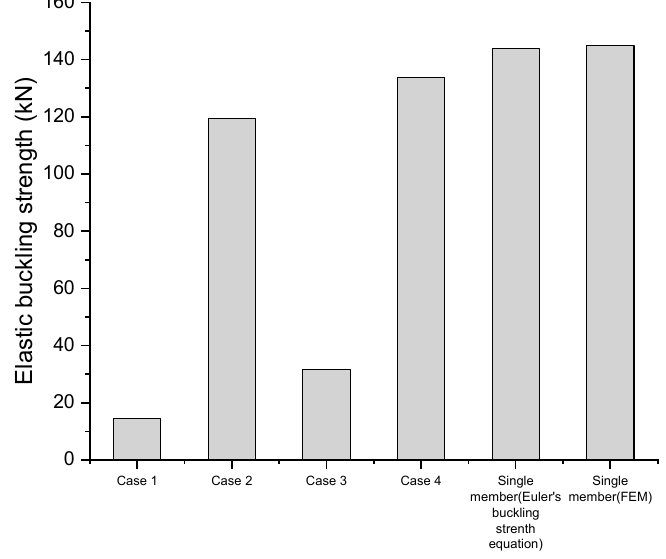
Figure 14. Comparison of elastic buckling strengths (first buckling mode; rotational stiffness not considered).